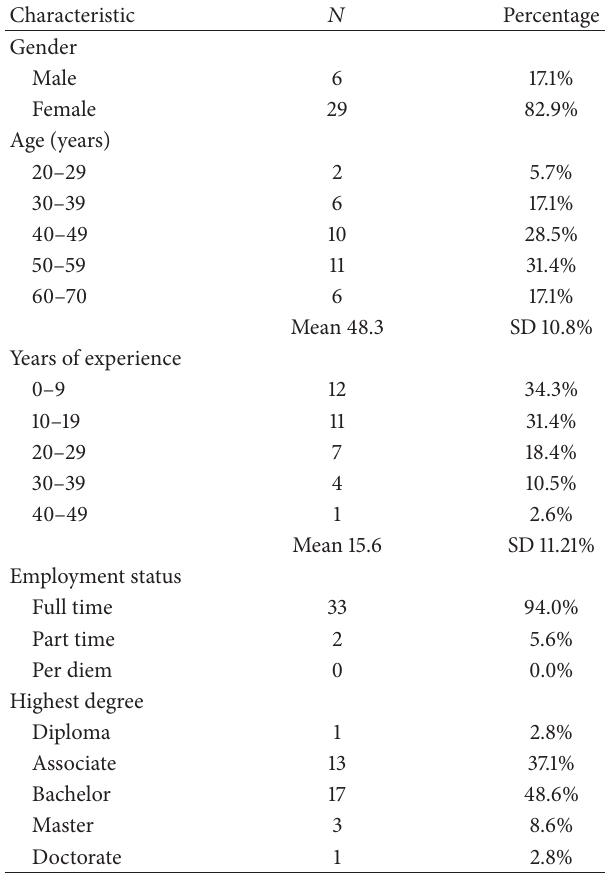
Table 1: Demographic information ( 𝑛 =